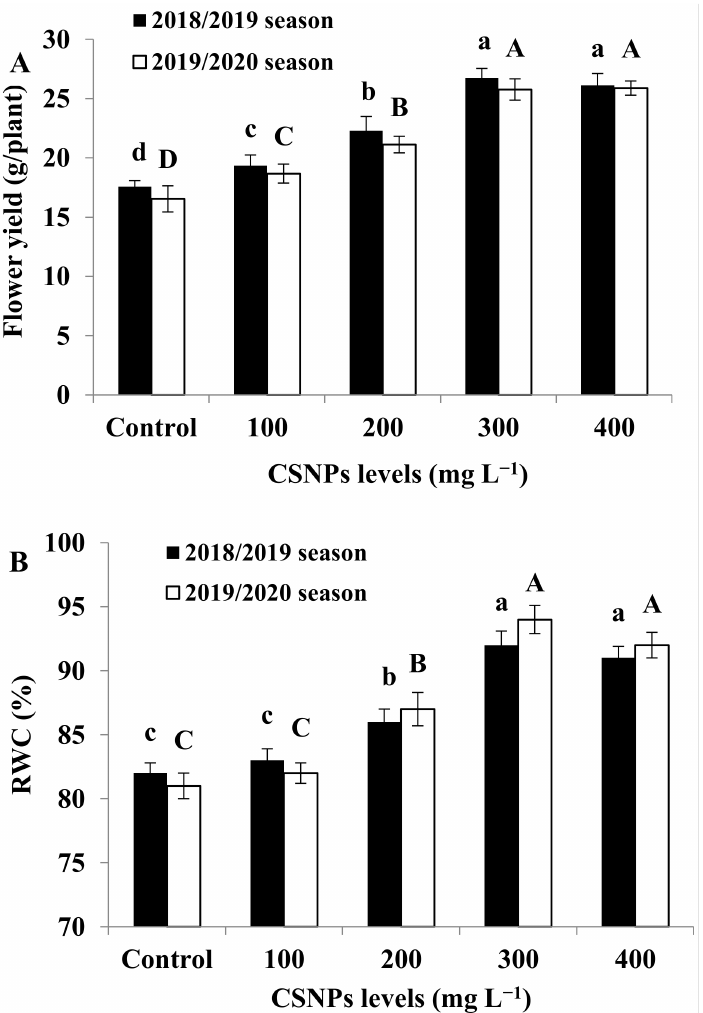
Figure 1. Impact of chitosan nanoparticles (CSNPs) on ( A ), dry flower yield; ( B ), relative water content of Matricaria chamomilla in the two experimental seasons. Data are means ± SE ( n = 3). In each season, letters represent statistical differences among the treatments at 5%